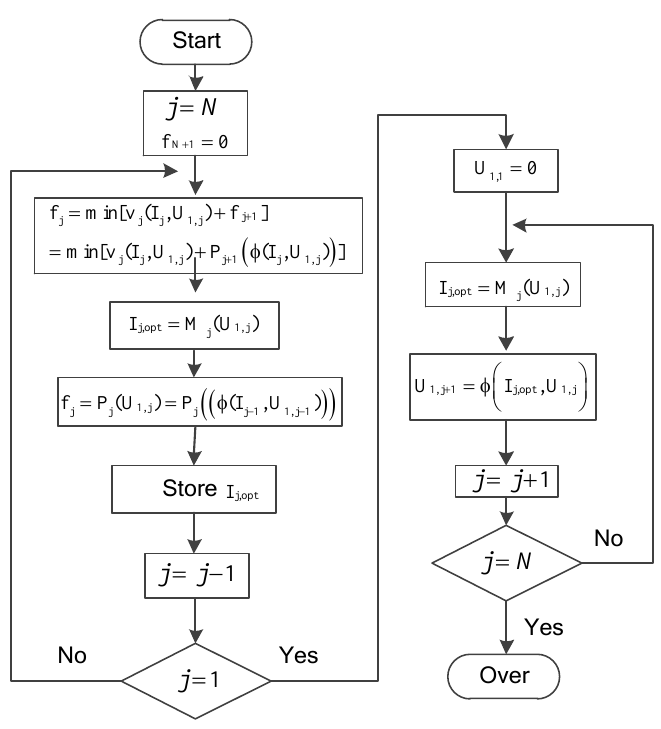
Figure 8. Flowchart of dynamic programming algorithm adopted to obtain current.